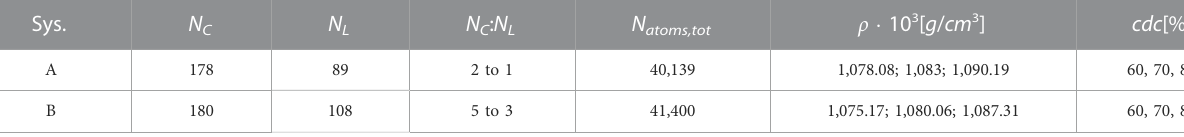
TABLE 1 Properties of systems A and B.